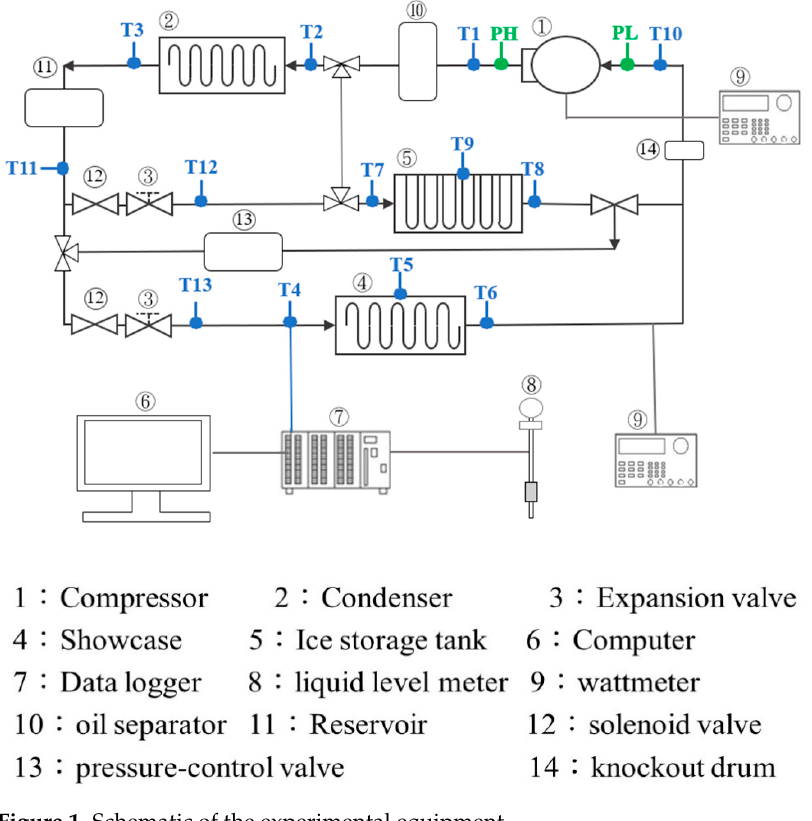
Figure 1. Schematic of the experimental equipment.